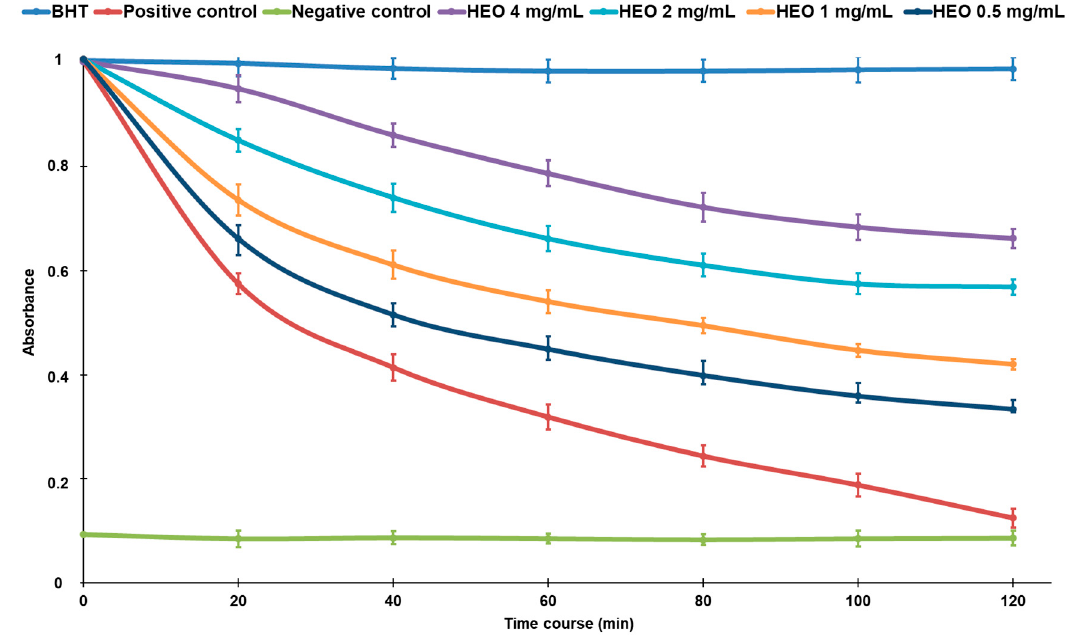
Figure 3. Beta-carotene bleaching curves of hull essential oil of Pistacia vera L. variety Bronte (HEO) at concentration range 0.5–4 mg/mL in respect to the reference compound butylated hydroxytoluene (BHT) (2 mg/mL). Results are expressed as mean ( n = 3) of three independent experiments.